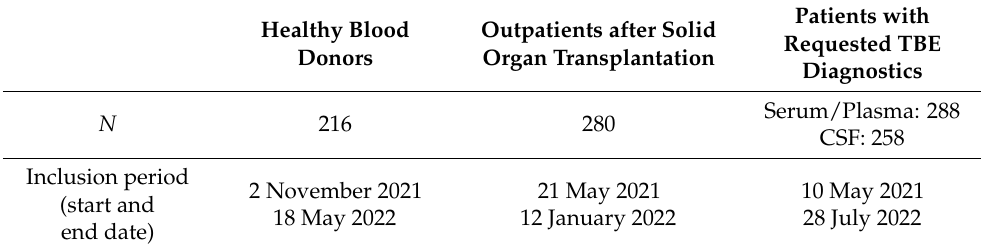
Table 1. Characteristics of study